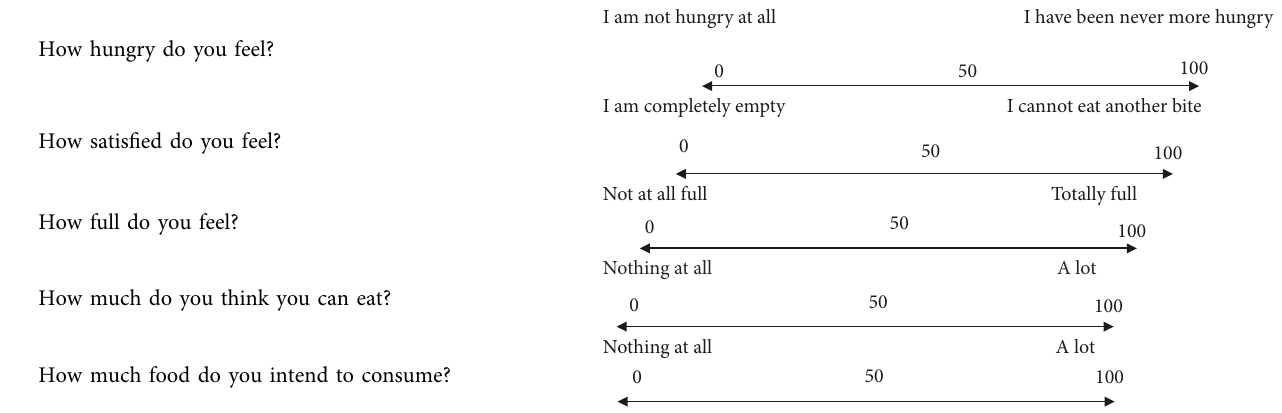
Table 2: Visual analogue scale for the appetite